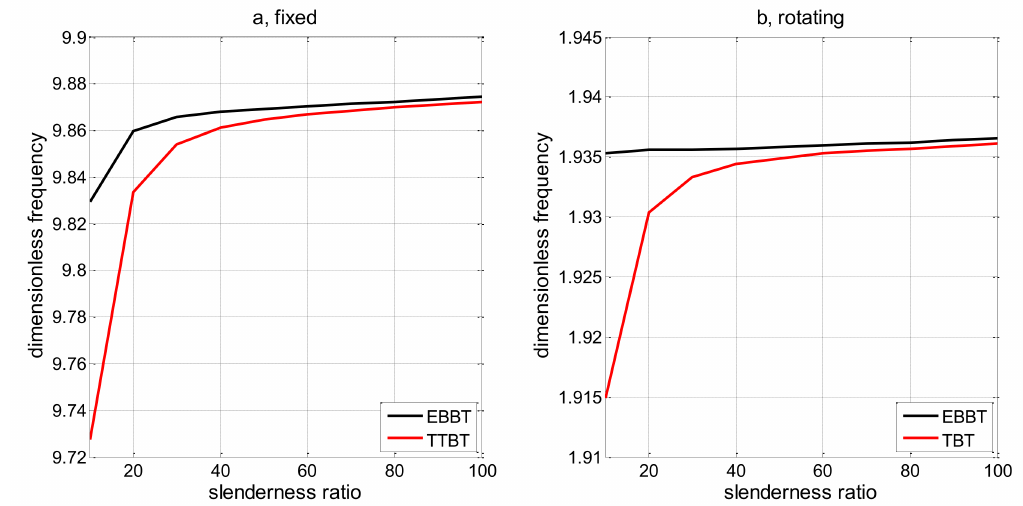
Figure 2. Variations of fundamental frequency with slenderness ratio (( a ) fixed micro-beam, ( b ) rotating micro-beam).